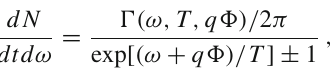
(green dotted) Pl Pl